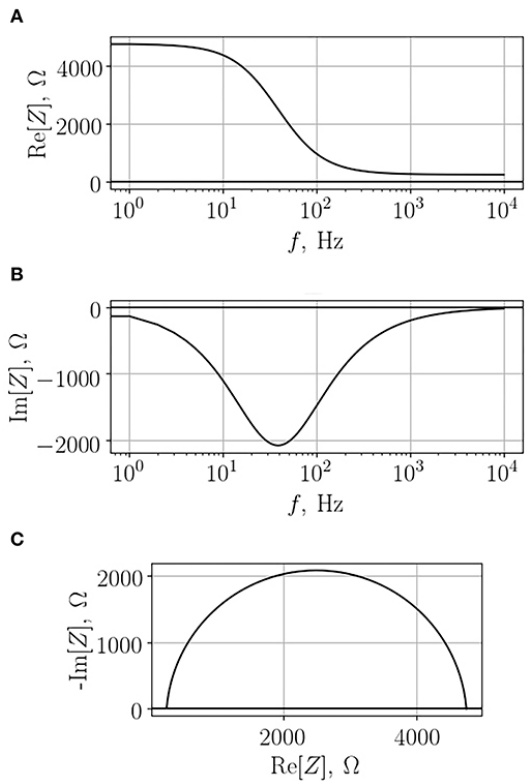
Figure 4. Typical electrochemical impedance spectroscopy (EIS) spectra obtained from a monolayer of cells. ( A ) The real component of the Bode plot, ( B ) the imaginary component of the Bode plot, and ( C ) the Nyquist plot in which the real impedance is plotted against the imaginary one. Adapted